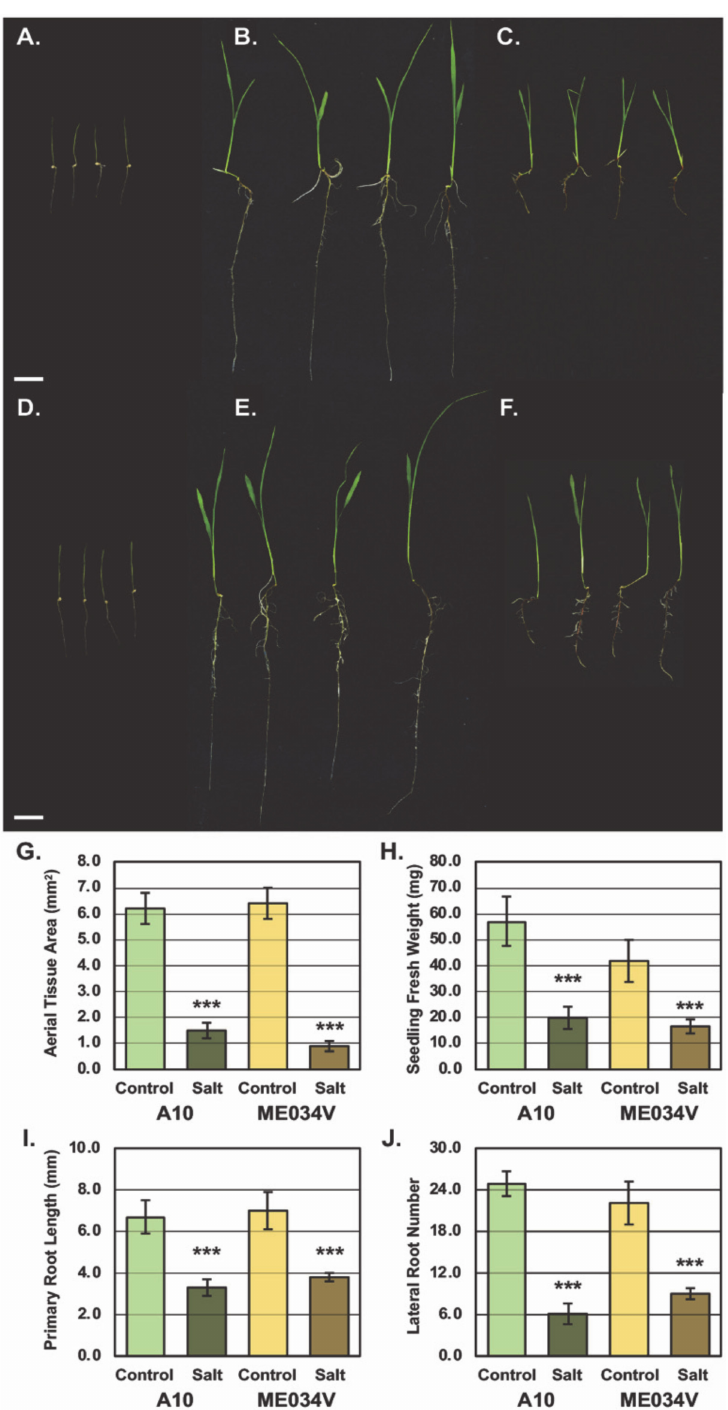
Figure 1. Assessment of the phenotypic response of Setaria viridis to salt stress. Phenotypes displayed by 3-day-old control ( A ), 10-day-old control ( B ), and 10-day-old salt stressed ( C ) S. viridis A10 seedlings. Representative phenotypes expressed by 3-day-old control ( D ), 10-day-old control ( E ), and 10-day-old salt stressed ( F ) S. viridis ME034V seedlings. Assessment of the phenotypic parameters, ( G ) aerial tissue area (mm 2 ), ( H ) seedling fresh weight (mg), ( I ) primary root length (mm), and ( J ) lateral root number, of 10-day-old control and salt stressed A10 and ME034V S. viridis seedlings. The bars on the histograms represent the standard deviation. Statistical data was analyzed by a t -test with the p -value indicated (*** p <